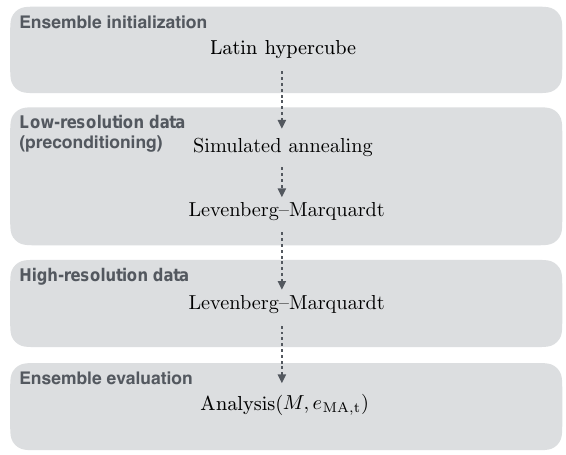
Figure 6. We choose a sequentially coupled parameter estimation procedure which (i) allows minimizing the computational cost and (ii) facilitates the implementation of tagging (Sect. 2.4.1). There- fore, Latin-hypercube-sampled parameter sets are preconditioned with a data set with reduced number of traces (low-resolution data) by sequentially coupling the simulated annealing algorithm and the Levenberg–Marquardt algorithm. The preconditioned parame- ter sets for each ensemble member serve as initial parameters for the final parameter estimation based on high-resolution data. The subsequent evaluation of the ensemble is based on the number of as- sociated events M and the mean absolute error in travel time e MA ,t (Sect.